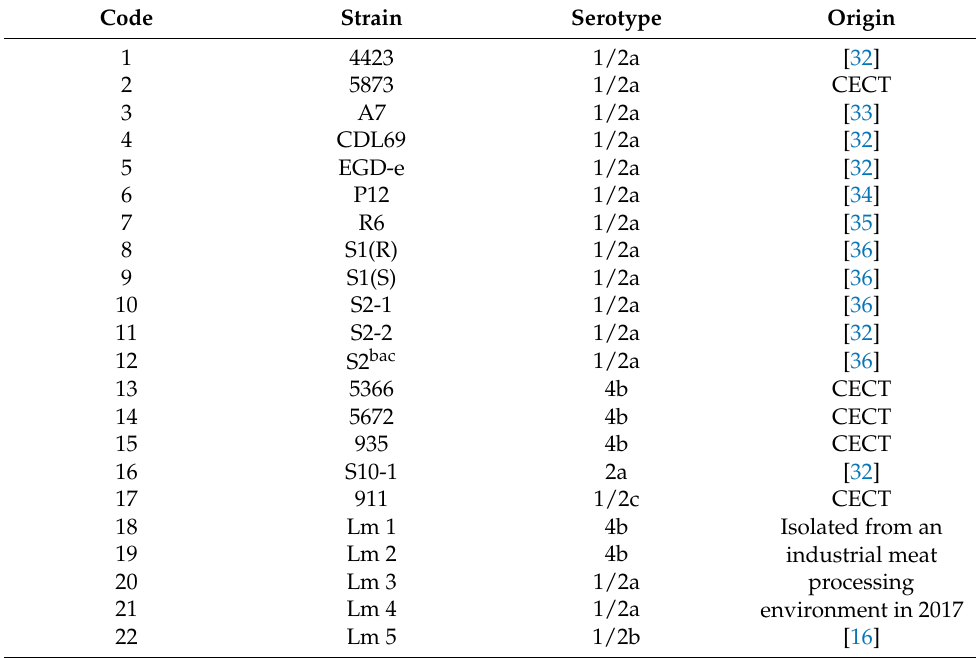
Table 1. Listeria monocytogenes strains used in the